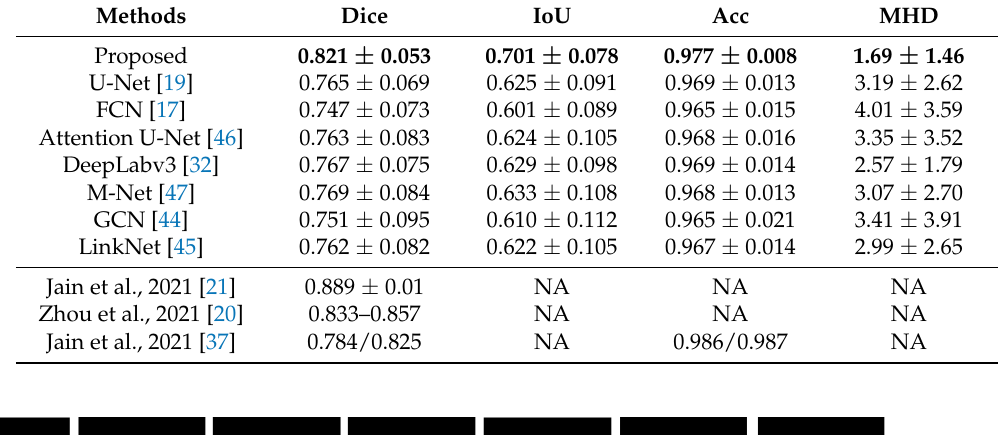
Table 2. Comparison between different methods on our dataset and some results on relevant papers, where the numbers in bold indicate the best results. It is worth noting that CBV training augmentation is used in all the methods. NA: not applicable.